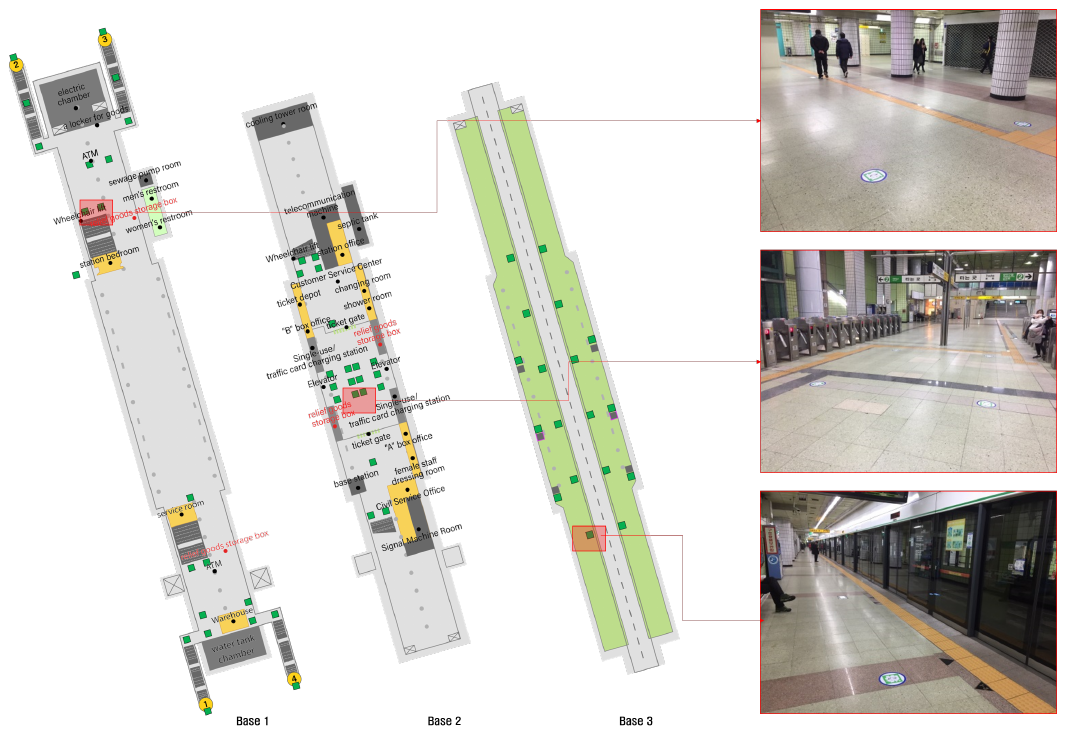
Figure 8. Testbed subway station for HMIPS test.